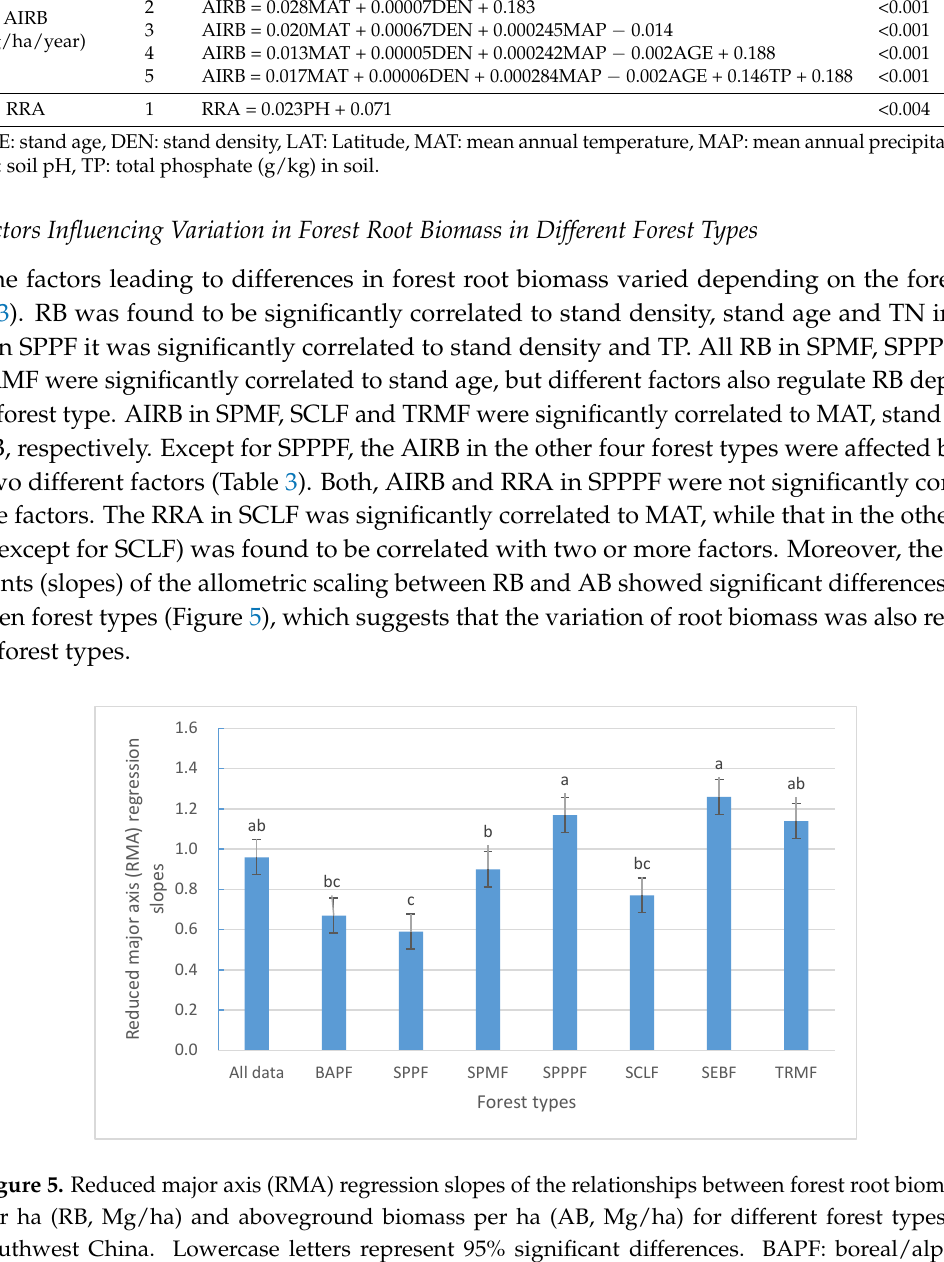
Table 2. Stepwise multiple regressions (SMR) between forest root biomass per ha (RB, Mg/ha), annual increment of root biomass per ha (AIRB, Mg/ha/year), ratio of root biomass per ha and aboveground biomass per ha (RRA) with stand characteristics and environmental factors in southwest China.